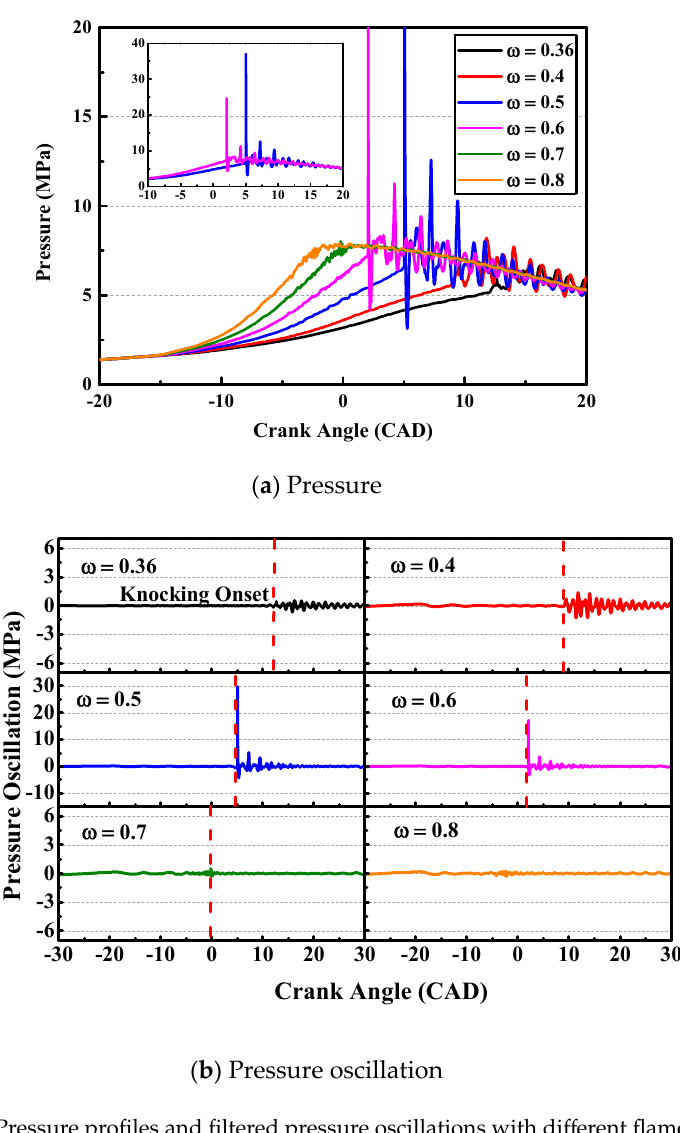
Figure 6. Pressure profiles and filtered pressure oscillations with different flame velocities.